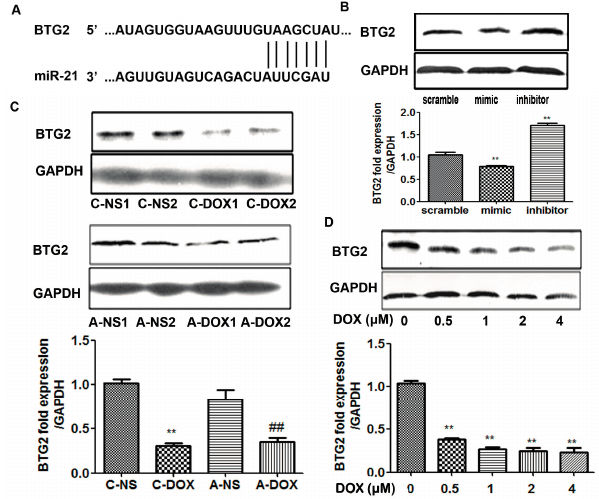
Figure 4. The expression of target mRNAs of miR-21 were tested by qRT-PCR. BCL2, B-cell CLL/lymphoma 2; STAT3, signal transducer and activator of transcription 3; BTG2, B cell translocation gene 2; FASLG, Fas ligand; FGF18, fibroblast growth factor 18; MEF2, myocyte enhancer factor 2C; NFIA, nuclear factor I/A; PDCD4, programmed cell death 4; TGFBI, transforming growth factor, β -induced. * , p < 0.05, compared with scramble, n = 3; ** , p < 0.01, compared with scramble, n = 3.